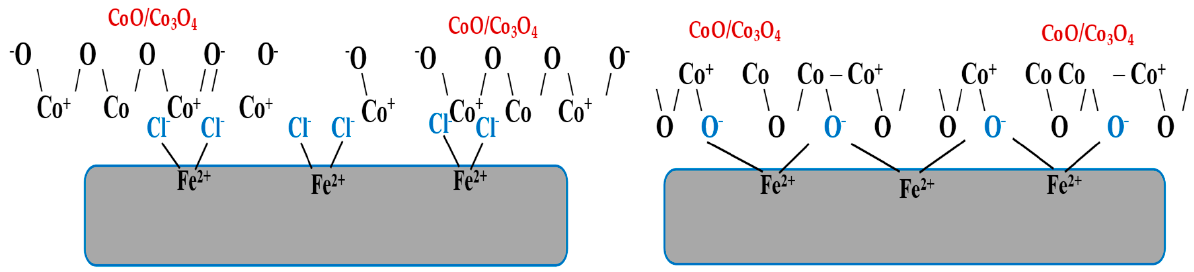
Figure 5. Mechanism of inhibiting low-carbon steel corrosion.